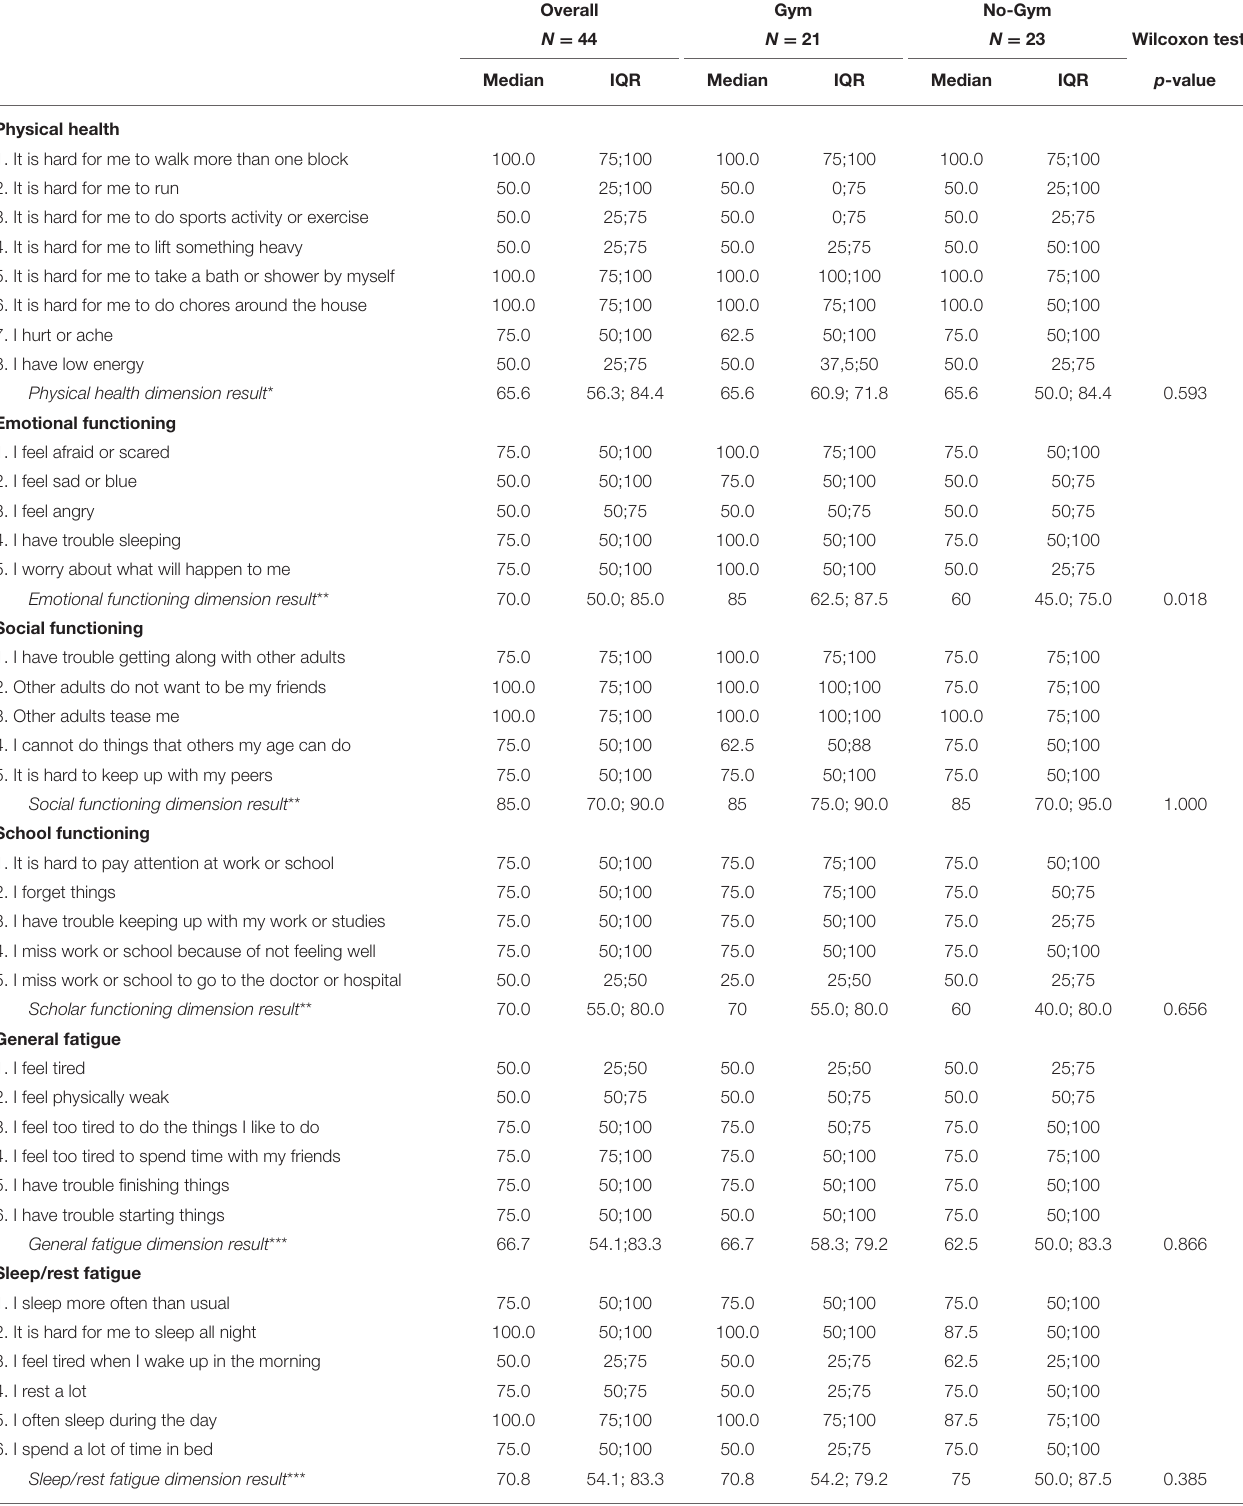
TABLE 2 | Scores obtained in the questionnaires by single item and single dimension, and overall, for the whole cohort and by study